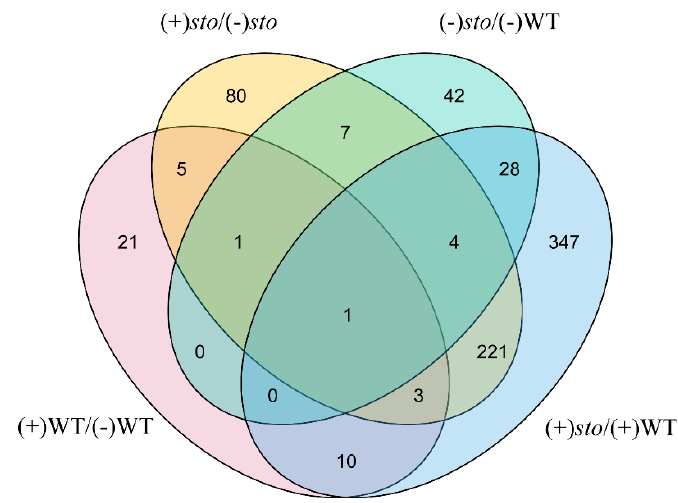
Figure 2. Venn diagram illustrating the number of identified proteins with abundance changed in WT and sto mutant before and after UV-B treatment.